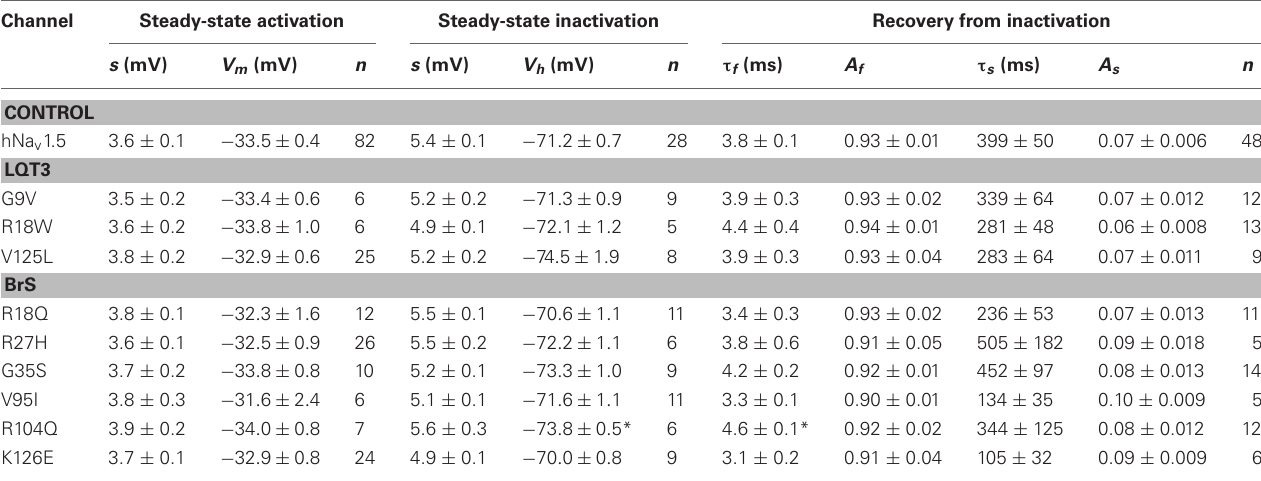
Table 3 | Electrophysiological properties of mutant hNa v 1.5 channels in Xenopus laevis oocytes. Channel Steady-state activation